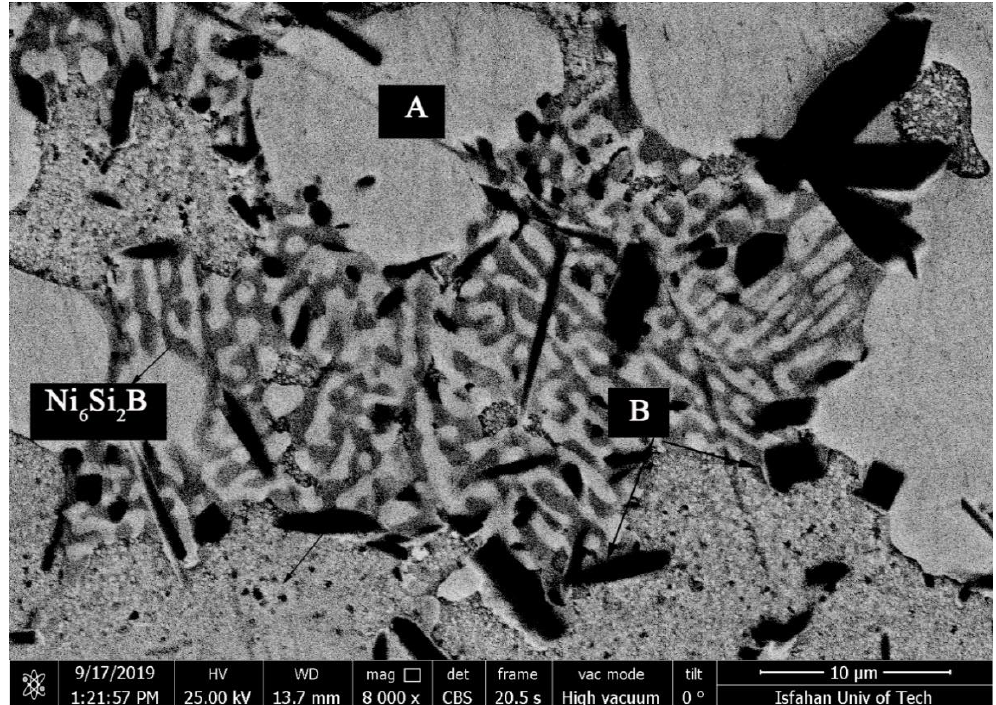
Figure 16. SEM image of the athermal solidification zone microstructure of the TLP-bonded specimen with the 1050 °C/10 min condition. Note: (A) Ni 3 B and (B) CrB/Cr 2 B.